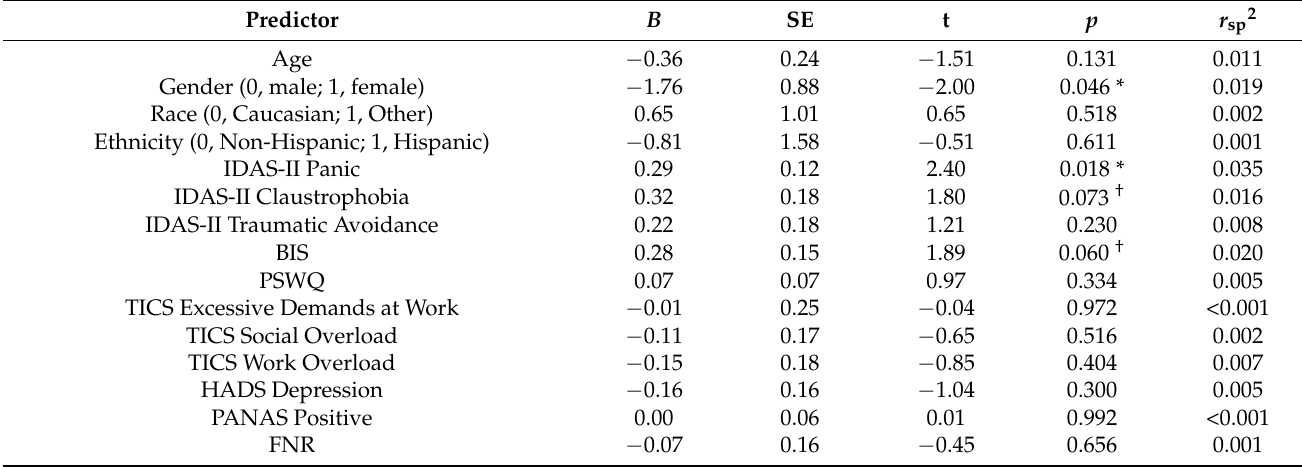
Table 2. Hierarchical multiple linear regression analysis results of the Research Domain Criteria Negative Valence Systems construct markers predicting fear of COVID-19.